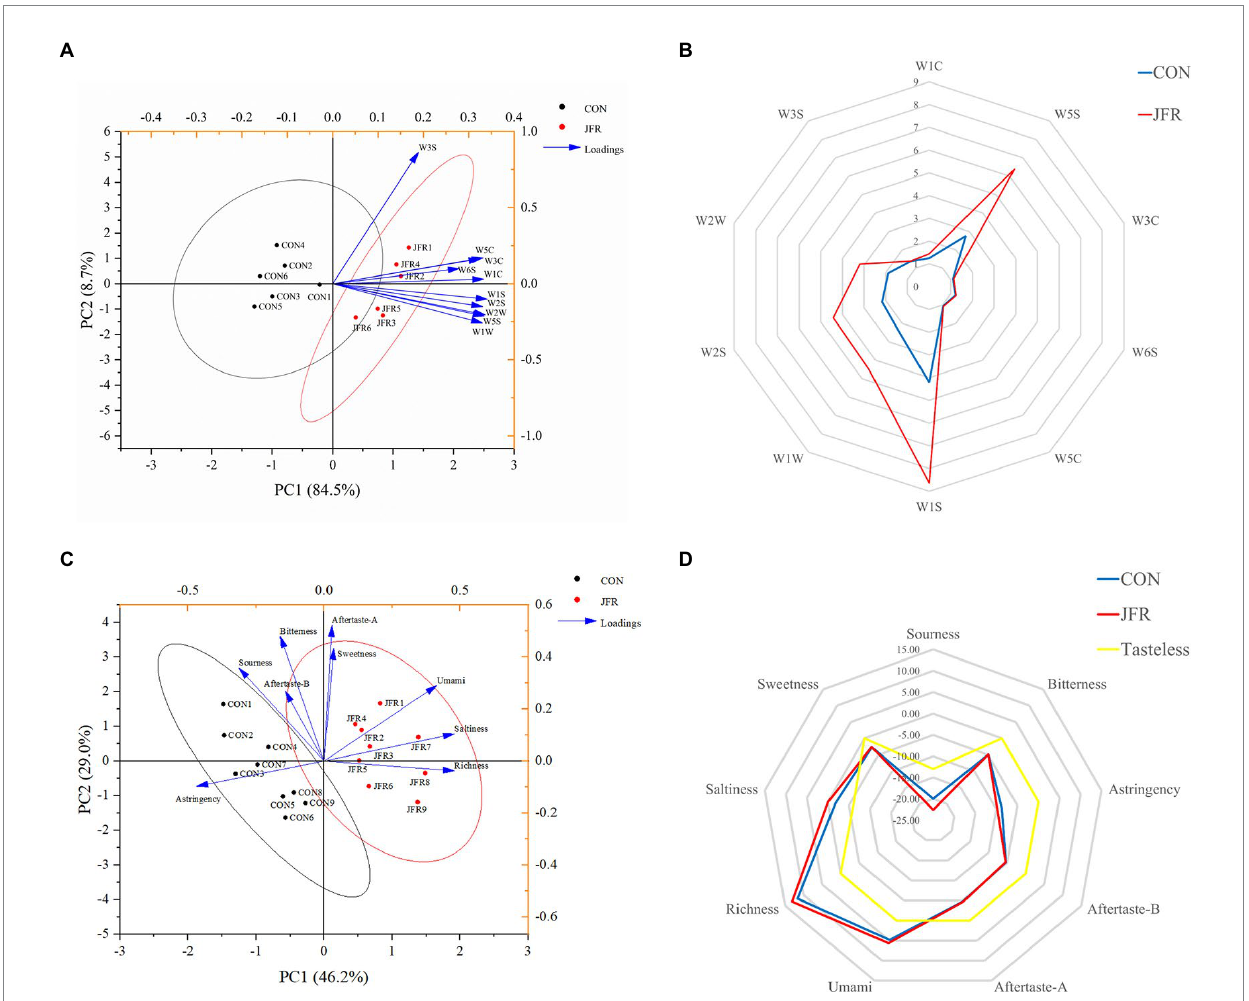
FIGURE 2 Effects of JFR on olfactory and taste characteristics. (A) Principal component analysis score map of goat meat aroma components based on electronic nose data. (B) Odor fingerprint of goat meat. The electronic nose system contained 10 sensors that were sensitive to different types of volatile substances: W1C (Benzene), W5S (Nitrogen oxides), W3C (ammonia), W6S (hydrogen), W5C (alkane), W1S (Short-chain alkanes), W1W (Inorganic sulfide), W2S (Alcohols, ethers, aldehydes, ketones), W2W (Organic sulfide), and W3S (Long-chain alkanes). (C) Principal component analysis score map of goat meat taste based on electronic tongue data. (D) Taste fingerprint of goat